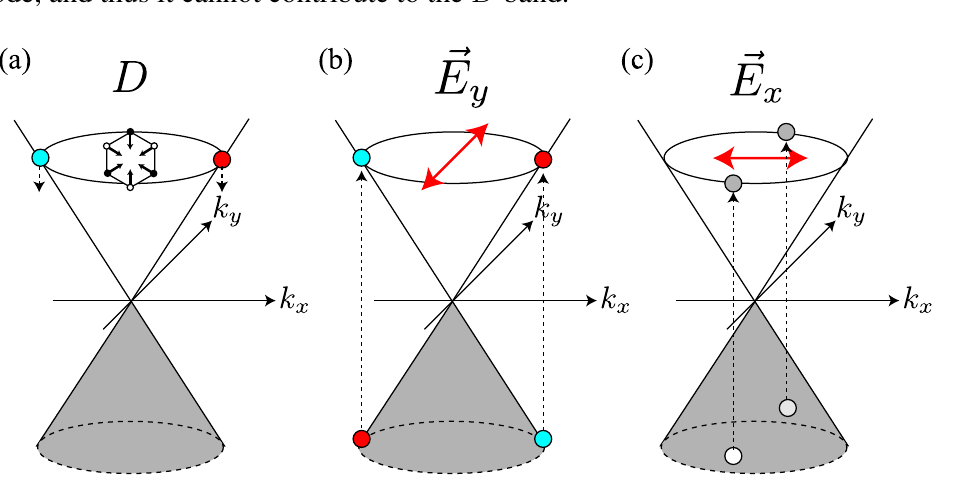
phonon is excited 1 g axis, the laser x can produce a x